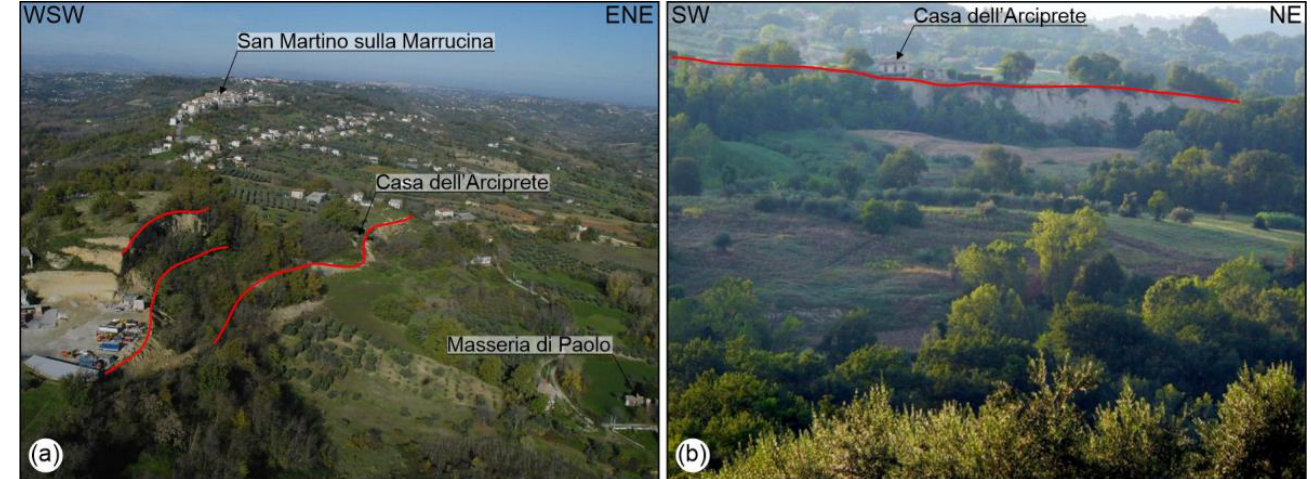
Figure 7. Photo documentation of geomorphological features of San Martino sulla Marruccina landslide. ( a ) Aerial view of the landslide area; ( b ) panoramic view of the landslide scarp of Casa dell’Arciprete. Red lines show the planimetric development of main landslide scarps.